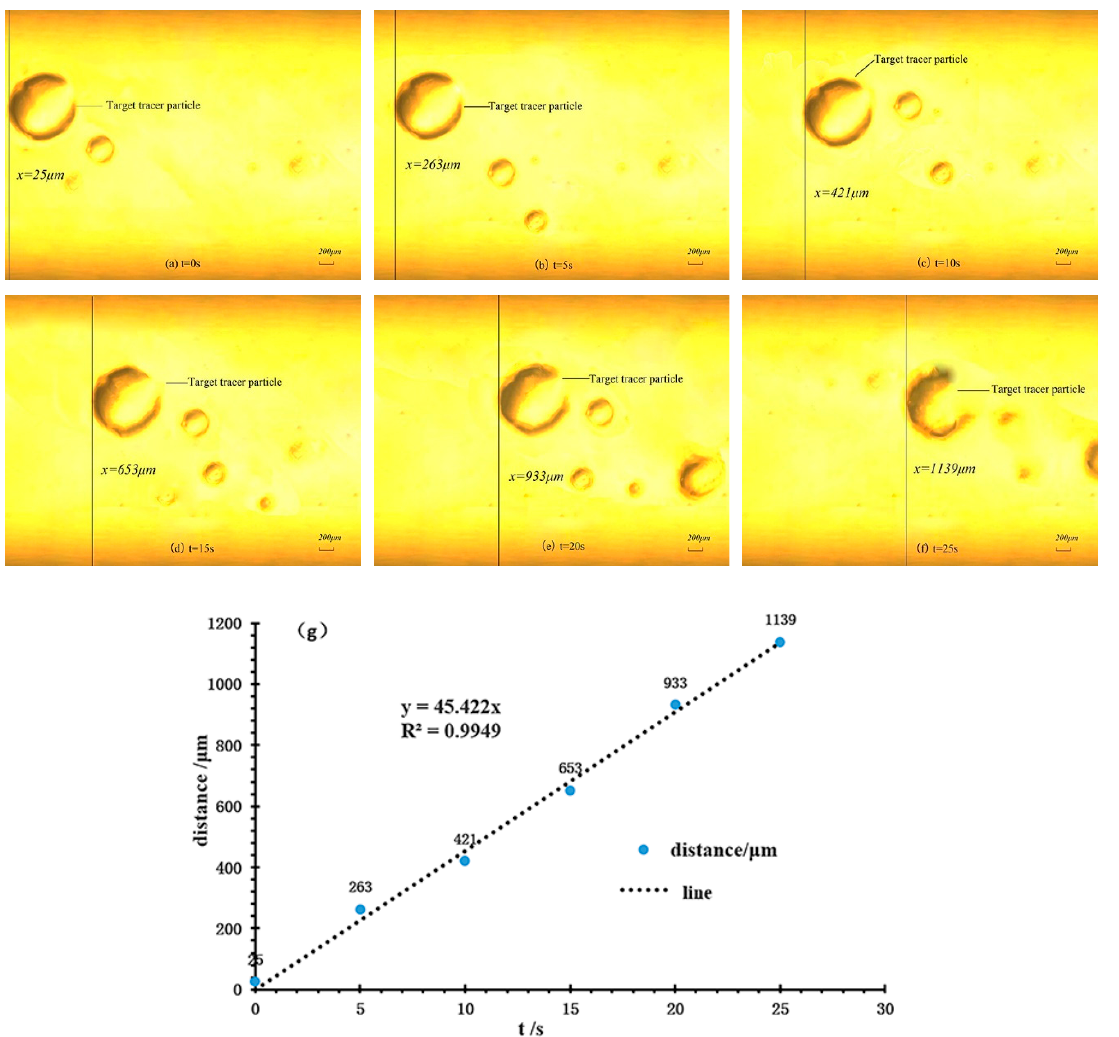
Figure 7. The motion of the LC molecule according to the testing under PZT of 70 Vpp, 100 Hz voltage and LC driving at 70 V. ( a – f ) The motion of PS particles in the flow field. ( g ) The curve of the LC molecule motion vs. time.